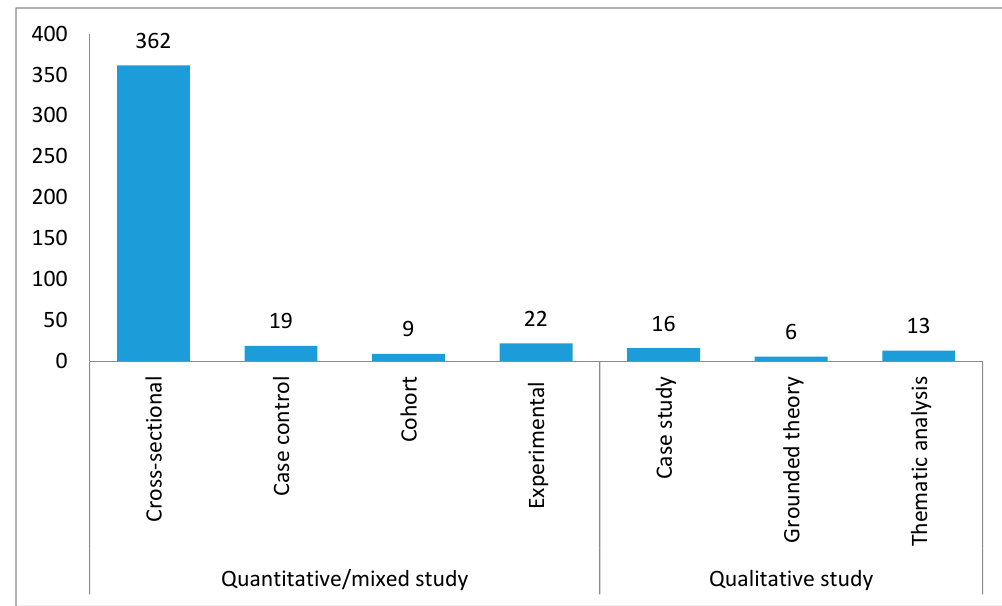
Figure 4. Types of Research Study Design in SSA (up to February 2017; n = 447).